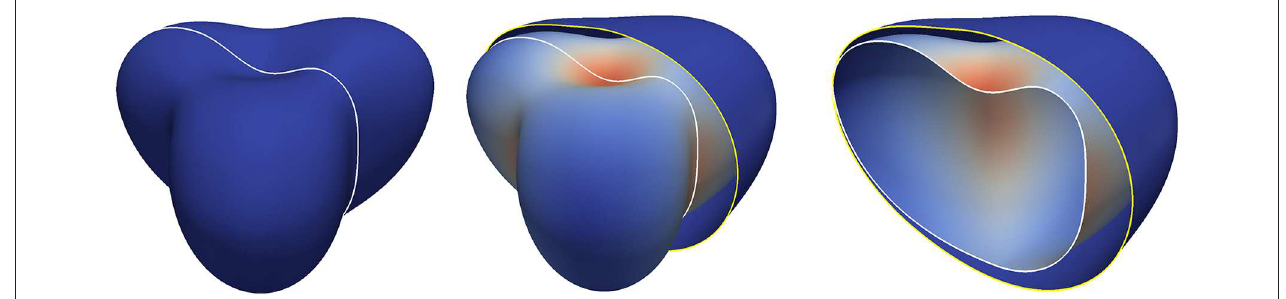
FIGURE 9 | Surface evolution with parameters given by Table 3 for the extended model in section 5.5 but with r c shows the initial surface. The white curve indicates a plane along which we cut the shapes for visualization purposes in Figures 10 , 11 . In the middle and on the right, both the initial surface and the deformed surface are displayed at the final time T the right to illustrate the cutting procedure. The coloring of the original surface indicates the magnitude of the deformation as in Figure 3 .